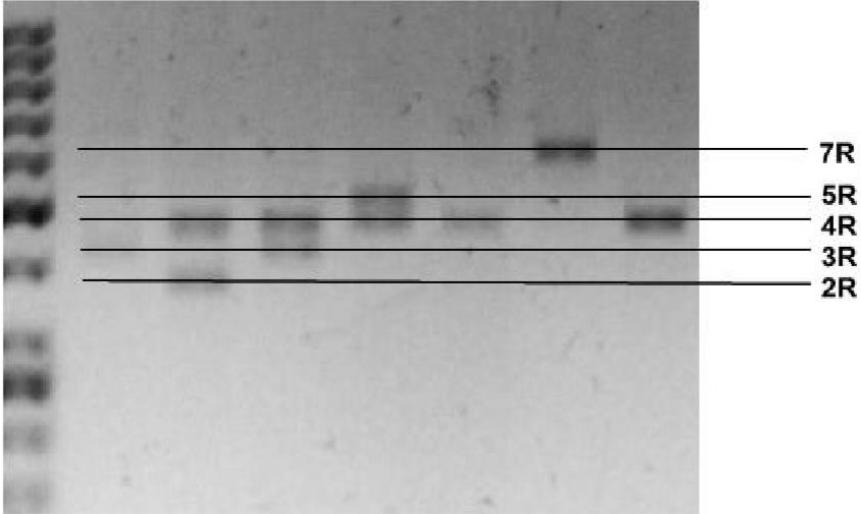
Figure 3. Photo of digested DRD4 PCR products. Representative photo of separated DRD4 PCR products depending on the genotype: LL—only 619 bp band (7R); S / S 379 bd (2R) or / and 427 bp (3R) or / and 523 bp (5R) band; L / S – 379 bd (2R) or 427 bp (3R) or 523 bp (5R) and 619 bp (7R) bands.